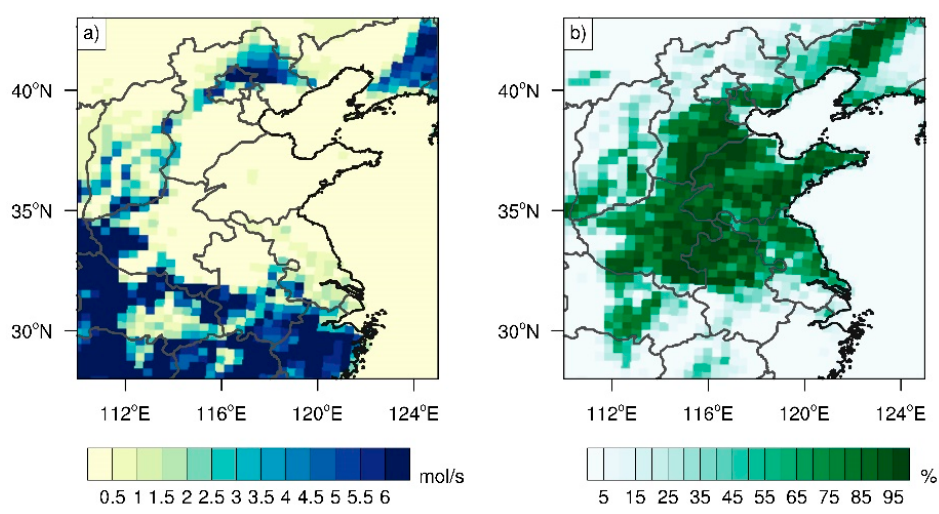
Figure 7. ( a ) Summer mean isoprene emissions (units: mol/s) during 2014–2019. ( b ) Spatial distribution of crops based on the land cover in 2016 from Moderate-Resolution Imaging Spectroradiometer (MODIS) data [62].